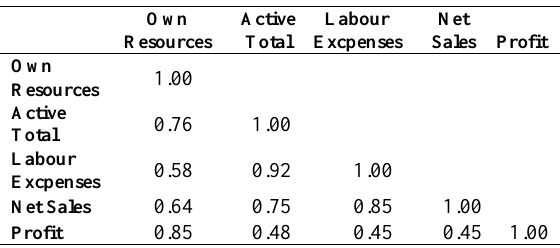
Table 4 . Correlation analysis results between ınput and